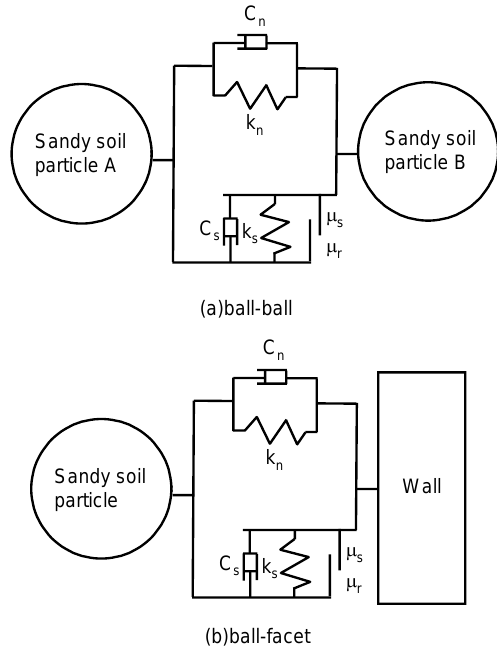
Figure 1. Discrete element contact model.